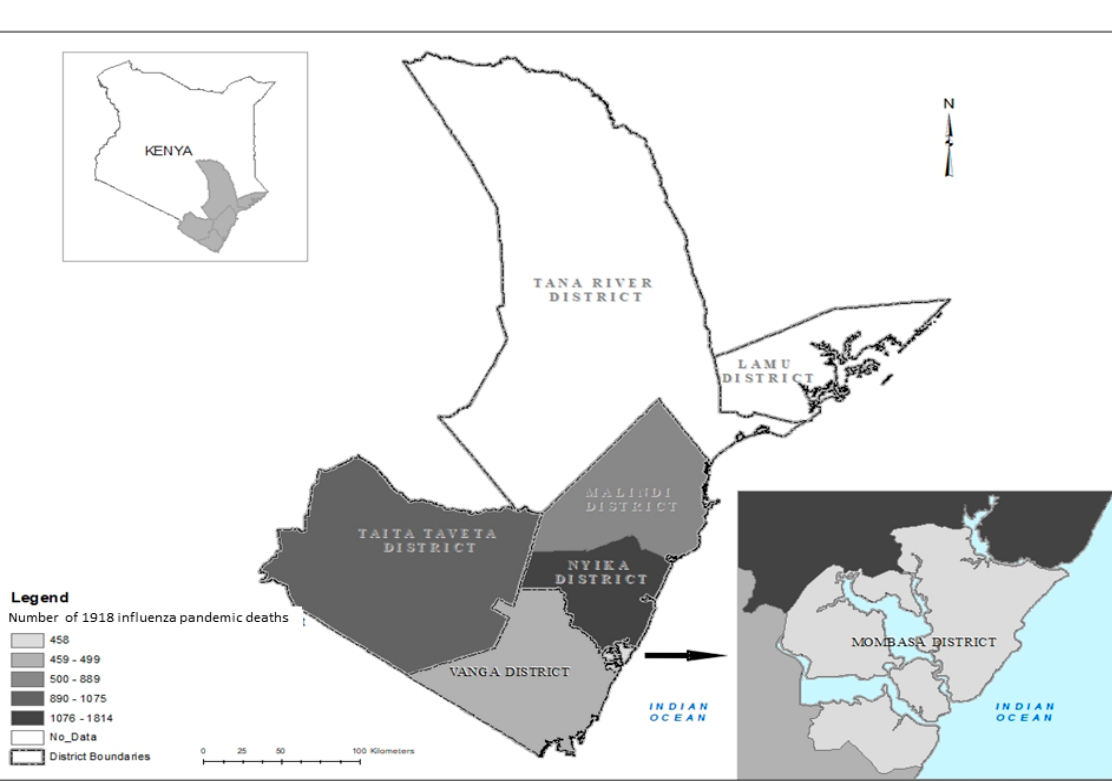
Figure 5. Number of reported 1918 influenza pandemic deaths in districts of Coast Province of Kenya, September 1918 to March 1919.